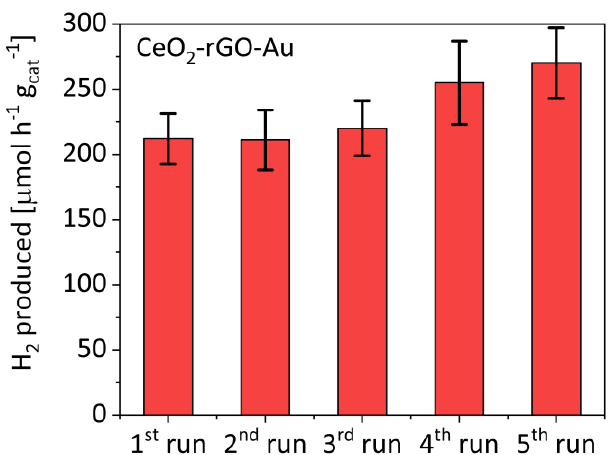
Figure 3. Photocatalytic activity of the CeO 2 -rGO-Au sample over five subsequent